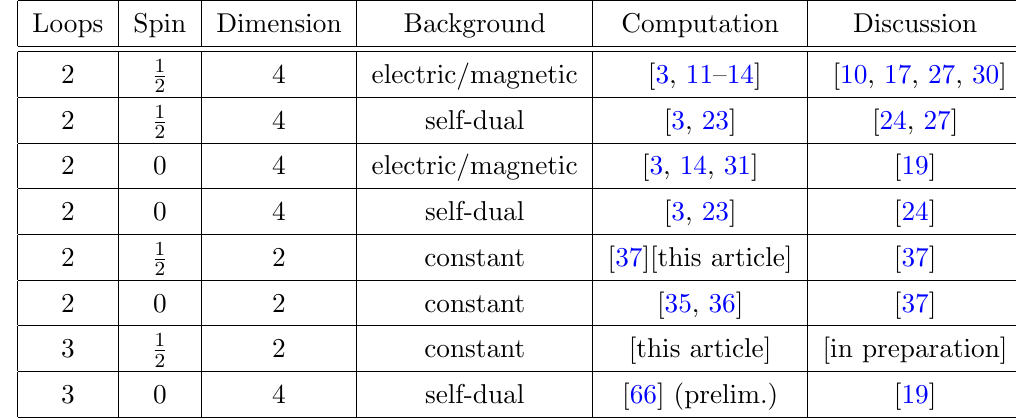
Table 2 . Summary of results on multiloop Euler-Heisenberg/Weisskopf Lagrangians.